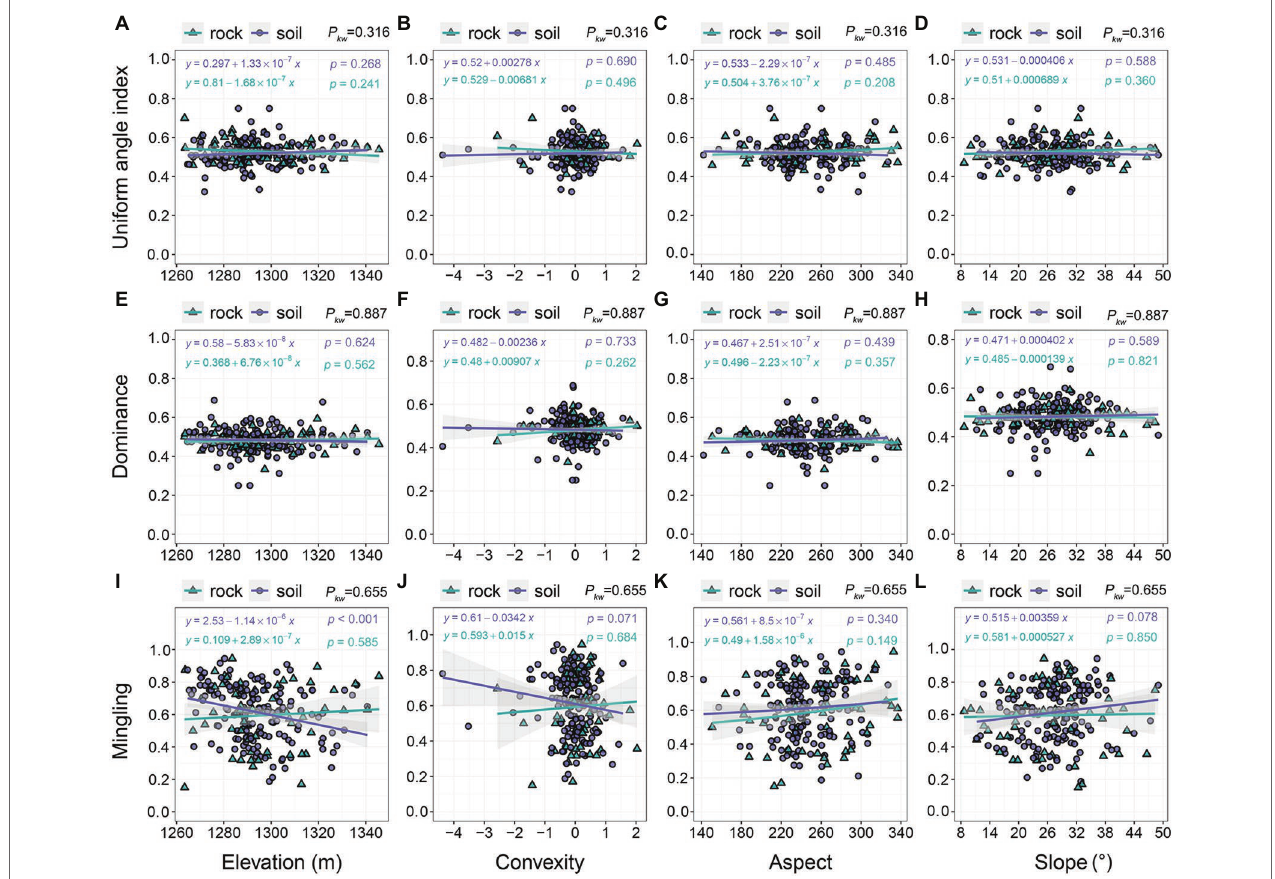
FIGURE 6 | The relationships of stand spatial structure parameters with topographic variables. p kw > 0.05, 0.01 < p kw < 0.05, and p kw < 0.01 represent non- significant, significant, and highly significant differences,